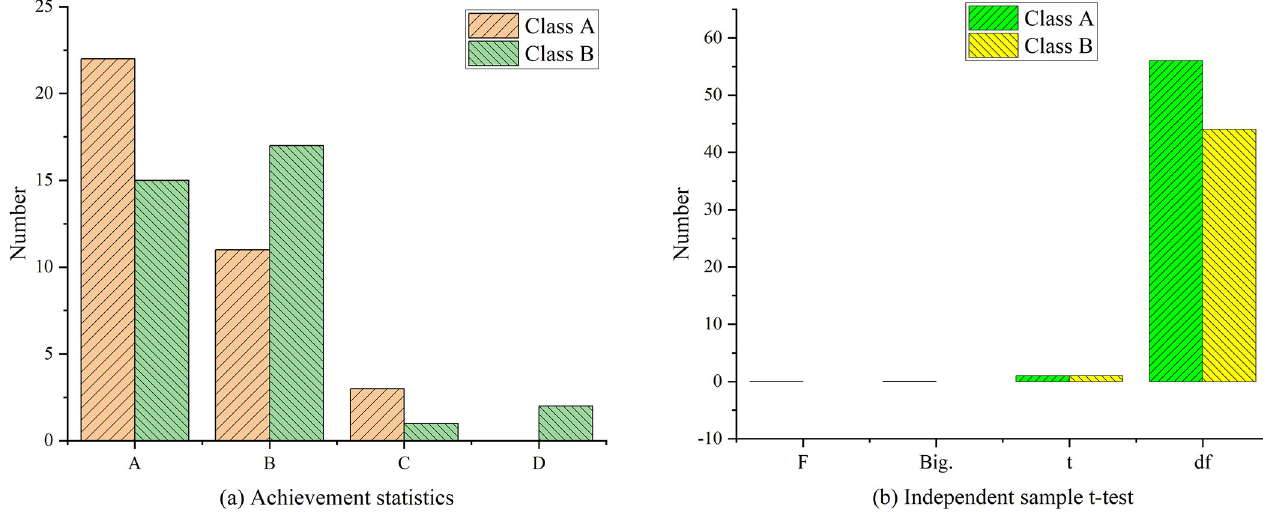
Fig 19. Statistical analysis of mid-term results. Note: A: 120 points—150 points; B: 90 points—119 points; C: 60 points—89 points; D: 0 points—59 points.